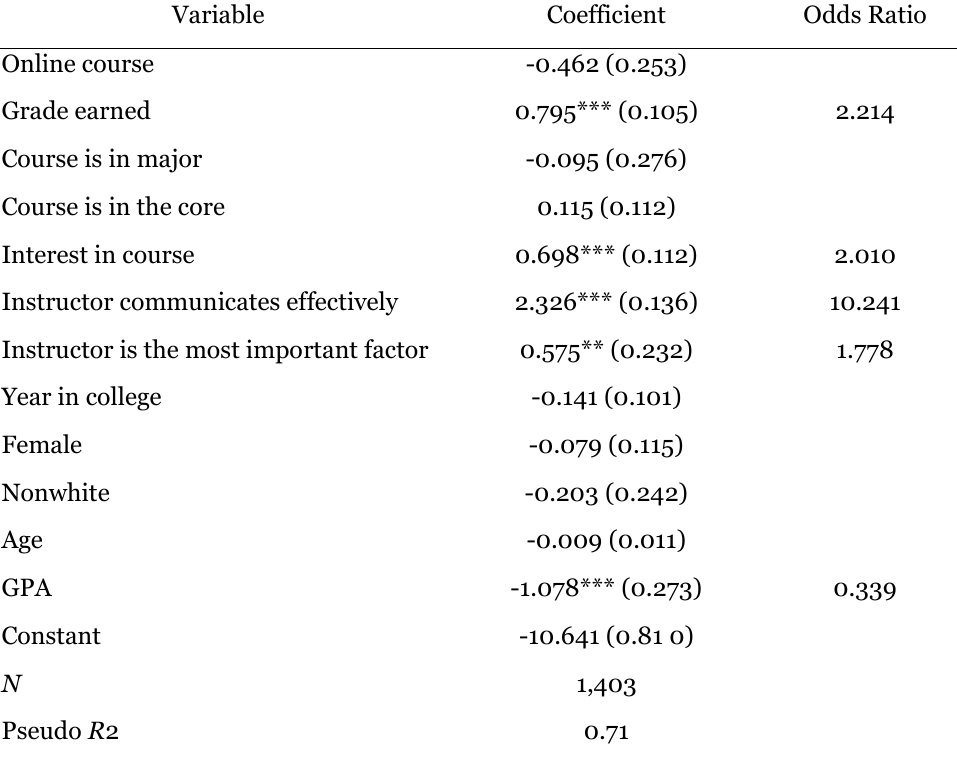
Logit Model of Best Class